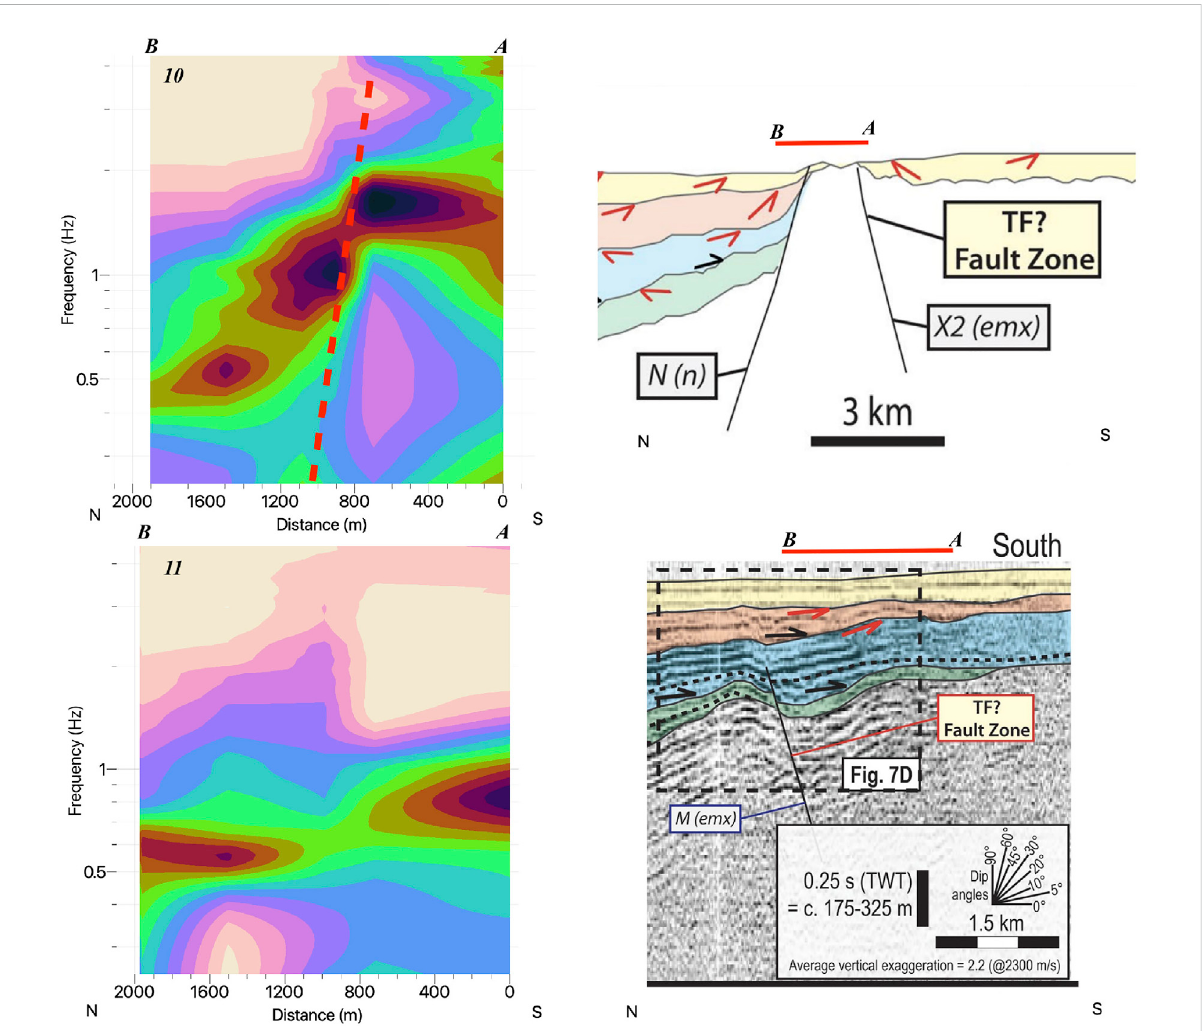
FIGURE 6 HVNSR contour plots of Section 10 and Section 11 located along seismic line 4 (top) and line 2 (bottom) interpreted in Patruno and Scisciani, (2021). The correspondence between the location of HVNSR contour-plot sections and the seismic line is reported with a red line and A and B extremes of the sections. A sketch of the hypothetical fault is also reported with a dotted red